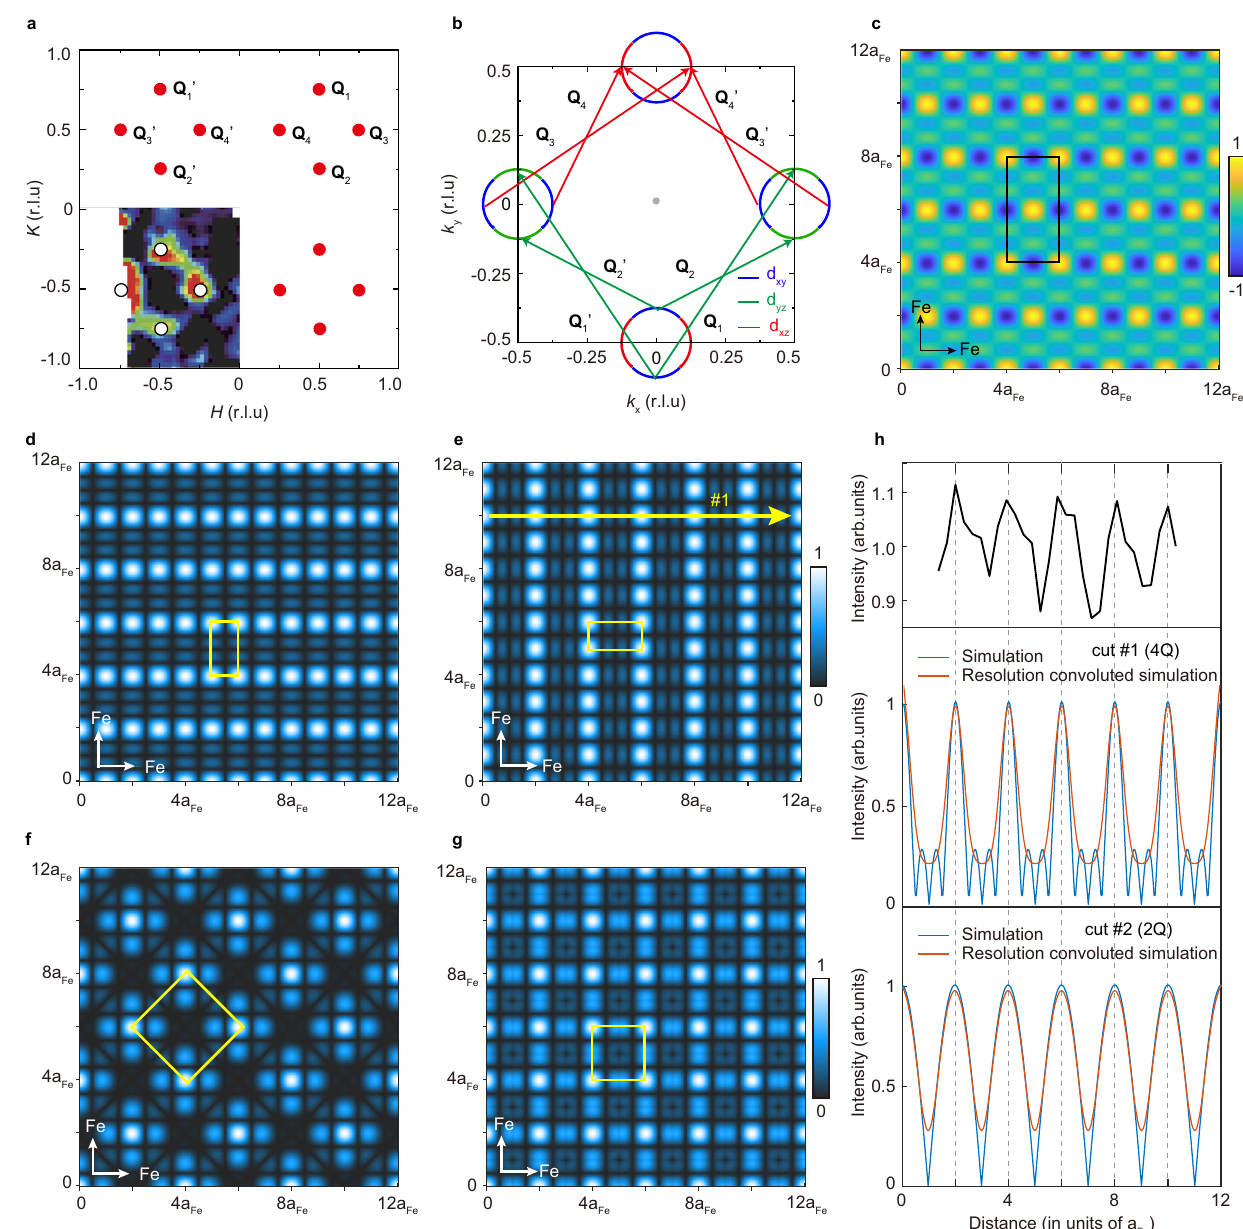
Fig. 5 | Simulation of spin and charge patterns in real space. a Momentum distribution of spin fl uctuations in (Li 0.84 Fe 0.16 OD)Fe 1 − x Se measured by INS in momentum space. The red dots mark the commensurate spin fl uctuation momenta, as shown in ( b ). b Cartoon of the corresponding scatterings between Fermi surface sections in the unfolded BZ for the momenta shown in ( a ). c The simulated SDW pattern based on four wave vectors: Q 1 = 0 : 5,0 : 75 ð